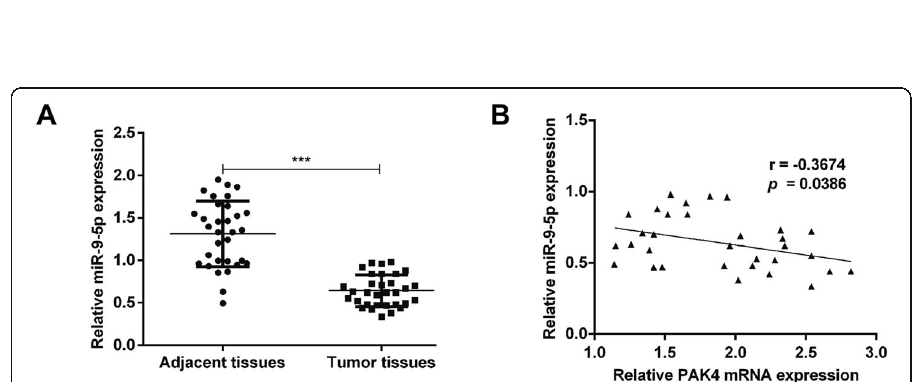
Fig. 4 The negative correlation between miR-9-5p and PAK4 in CRC tissues. a Lower expression of miR-9-5p was observed in 32 CRC tissue samples than in the matched adjacent tissues (determined using quantitative real-time PCR). *** p < 0.001; b The correlation between PAK4 and miR-9-5p in the 32 CRC clinical samples was analyzed using Spearman ’ s rank